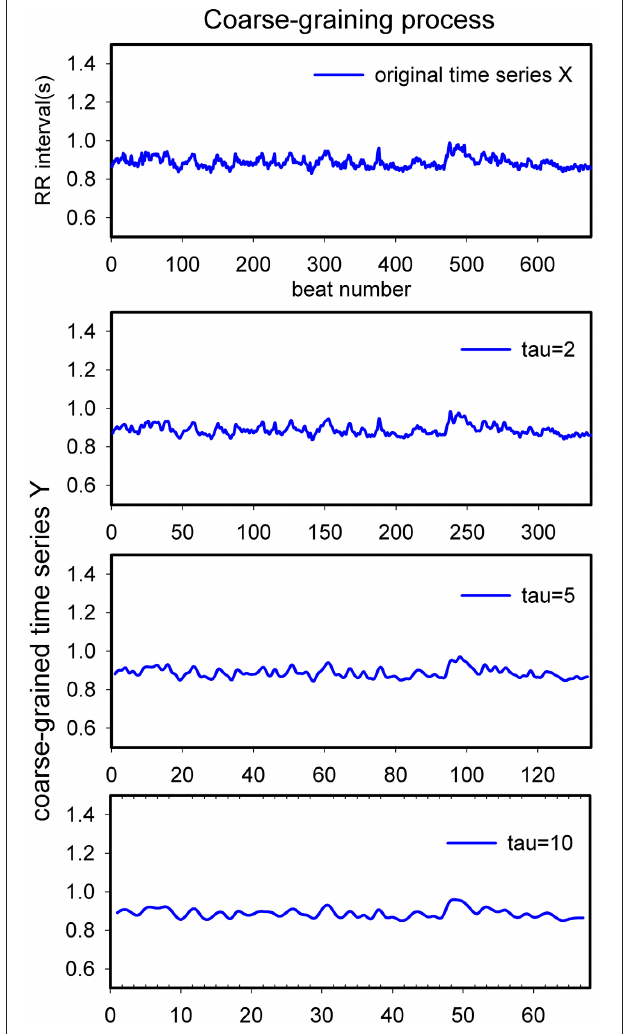
FIGURE 1 | Schematic diagram of the process of coarse-graining. This is a representative ∼ 10min heart rate recording from a healthy volunteer in supine position. From top to bottom tau = 1 , 2 , 5 , 10. X-scale: item number in the series; Y-scale: (averaged) duration of heart periods in